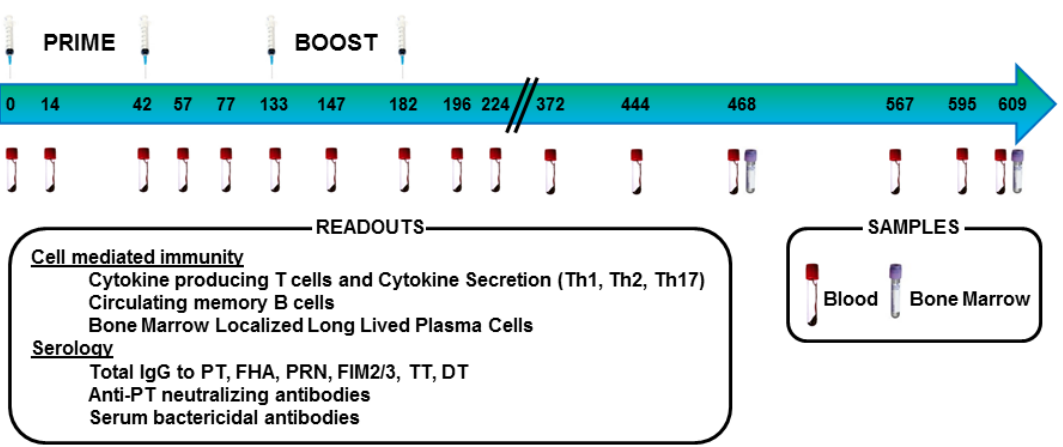
Figure 1. Immunization and sample collection timeline.